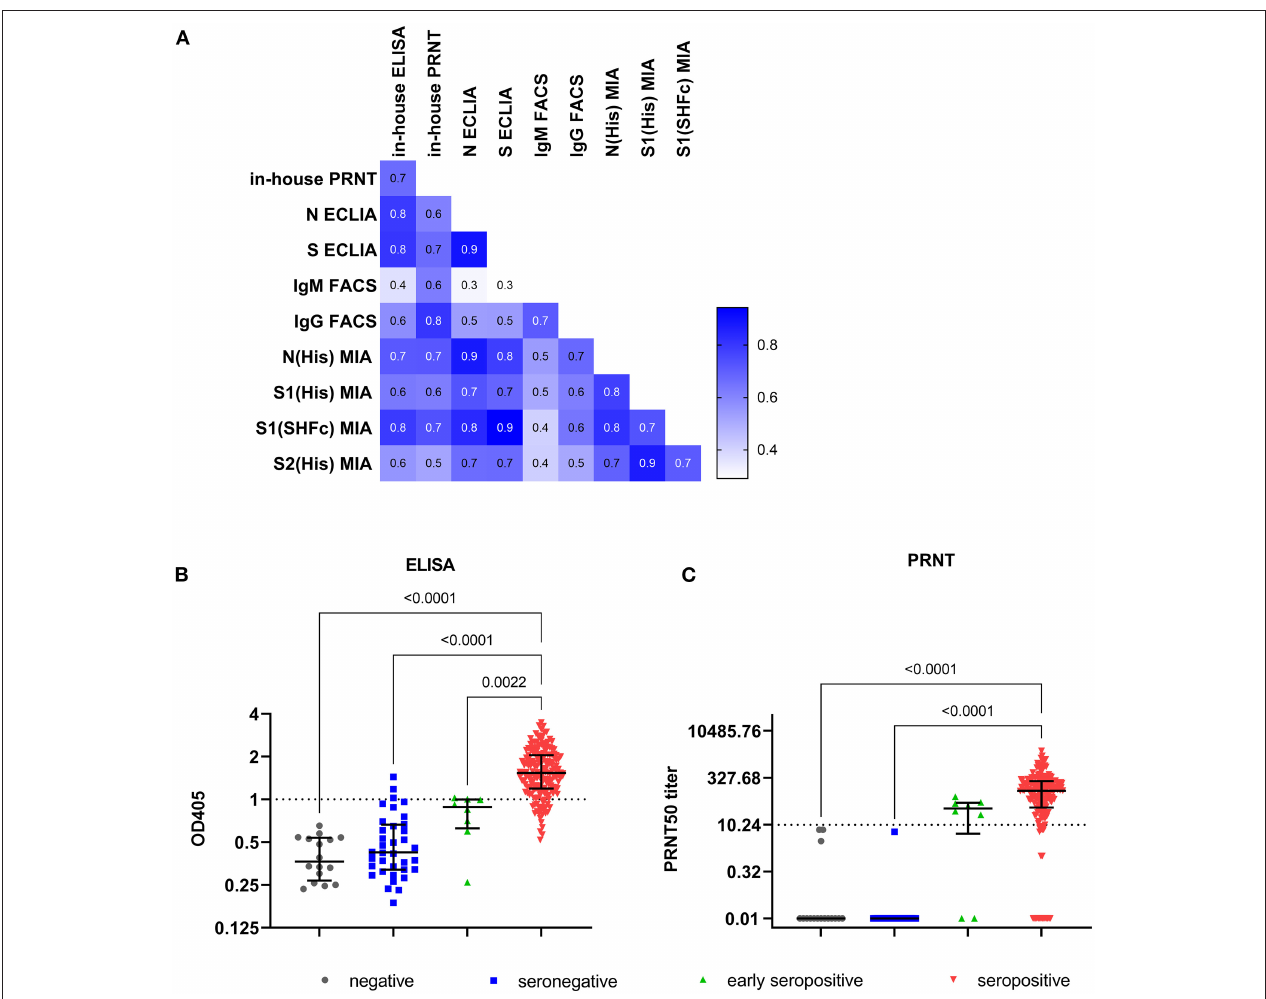
FIGURE 1 | Results of in-house ELISA and PRNT. (A) Correlation matrix with Spearman r values of all investigated serology assay: anti-S IgM and anti-S IgG determined by flow cytometry (IgM FACS and IgG FACS, respectively), N- and S-targeting CLIA (N and S ECLIA), in-house IgG ELISA and PRNT. Individual result of each sample (total 250) for (B) in-house ELISA, and (C) in-house PRNT. Lines represent median and interquartile range. The respective thresholds (dotted line) are for in-house IgG ELISA OD 405 ≥ 1, and for PRNT ≥ 1PRNT 50 titer. The samples were categorized based on their SARS-CoV-2 RT-PCR result in PCR negative (n = 16; gray), and in 3 groups of SARS-CoV-2 confirmed cases: seronegative samples (n = 36; blue) with negative results in the flow cytometry based assay and ECLIAs, early seropositive samples ( n = 8; green) that are positive for anti-S IgM, and seropositive samples ( n = 190; red) that are positive for anti-S IgG determined by flow cytometry and/or in one or both ECLIAs. Multiple comparison was performed by Kruskal-Wallis test with α =